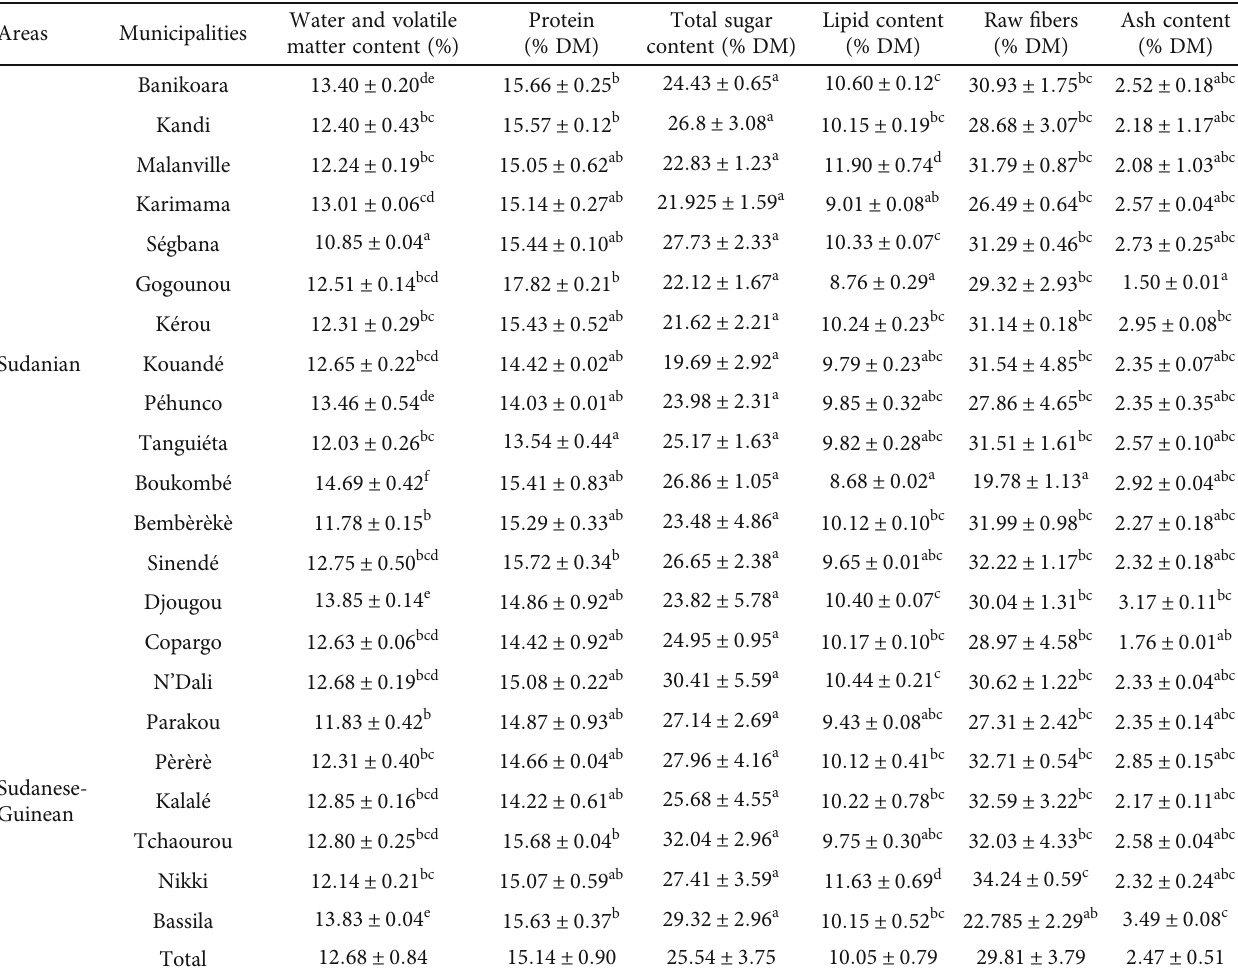
Table 1: Proximate composition of Detarium microcarpum seeds in North Benin.